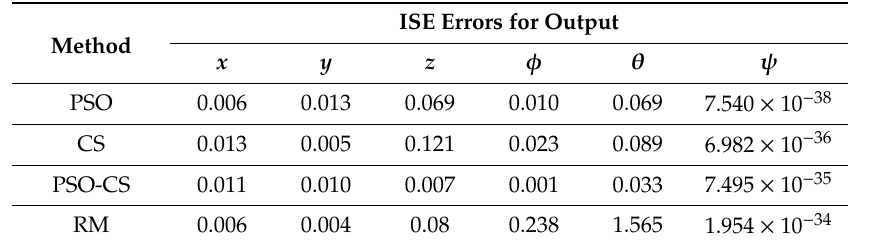
Table 7. Errors (ISE-Integral Square Error) obtained with Particle Swarm Optimization (PSO), Cucko Search (CS), Particle Swarm Optimization-Cuckoo Search (PSO-CS), and Reference Model (RM) for the quadrotor (helical trajectory).